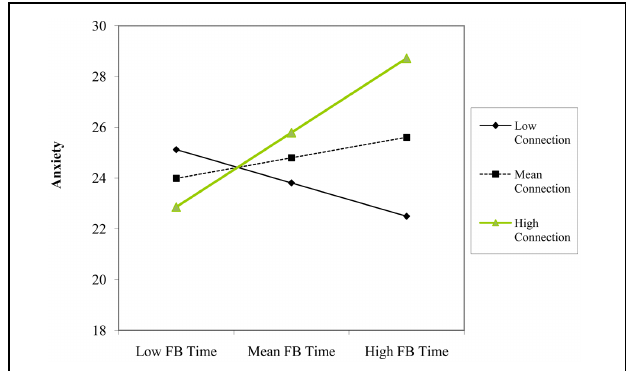
FIGURE 7 | Participant’s Facebook time and connection level as interactive predictors of scores on anxiety